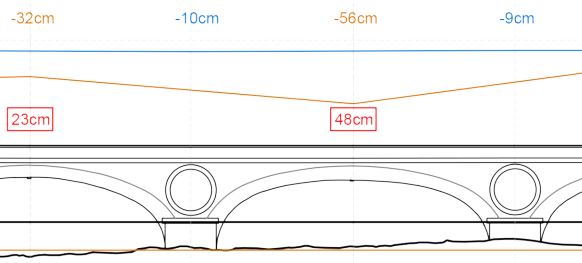
Figure 4. The differences in the piles and keystones levels (here reported only for the arch n. 2) supply indications about the possible settlements and deformations suffered by the structure.